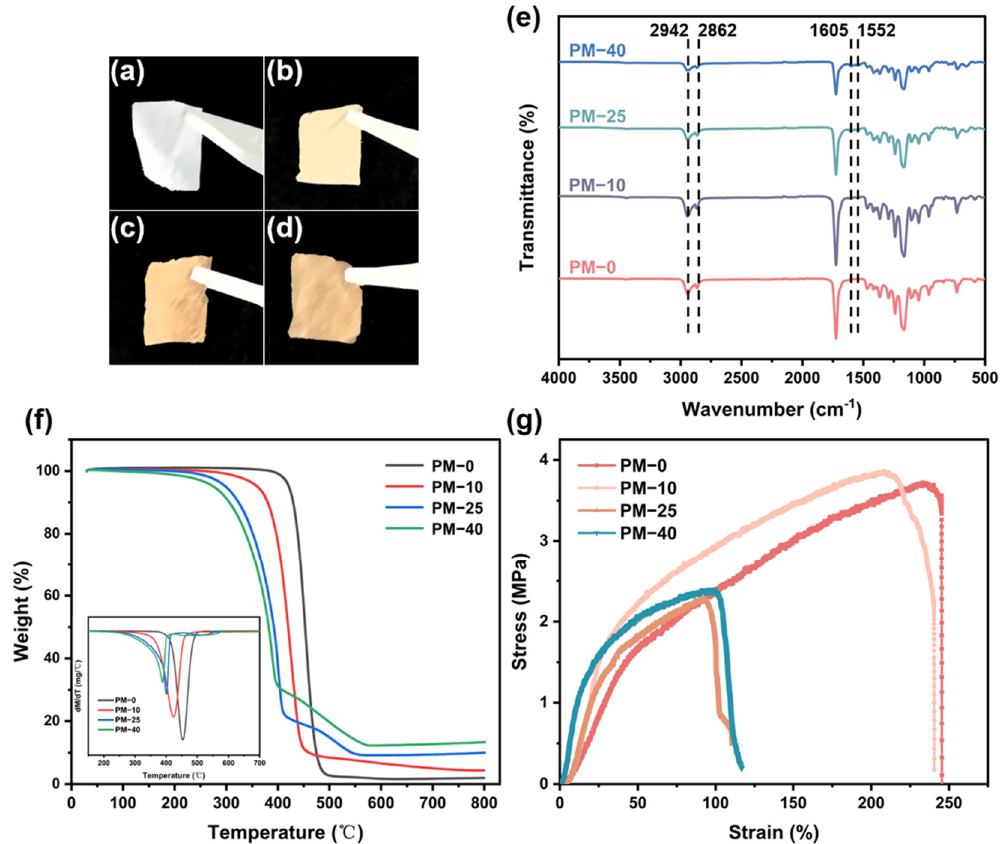
Figure 4. Photographs of the PM − 0 ( a ), PM − 10 ( b ), PM − 25 ( c ), and PM − 40 ( d ) NFMs. ( e ) FTIR spectra of PM − 0, PM − 10, PM − 25, and PM − 40 NFMs. ( f ) Thermogravimetric analysis (TGA) curves of nanocomposite fibrous membranes, the inset show the corresponding DTG analysis of PM − 0, PM − 10, PM − 25, and PM − 40 NFMs. ( g ) The mechanical properties of PM − 0, PM − 10, PM − 25, and PM − 40 NFMs.